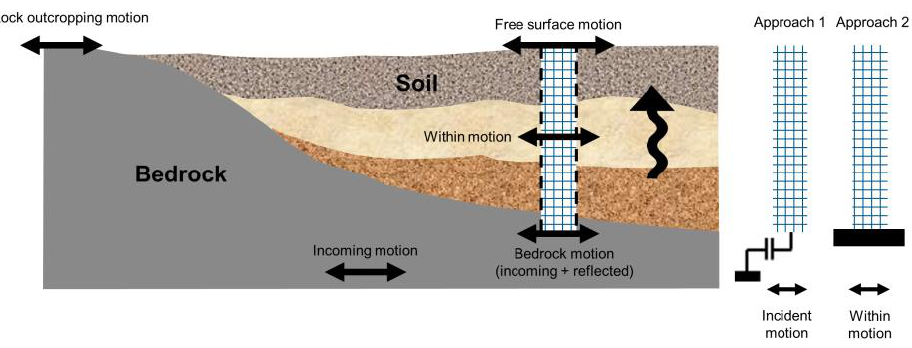
Figure 1. One-dimensional site analysis